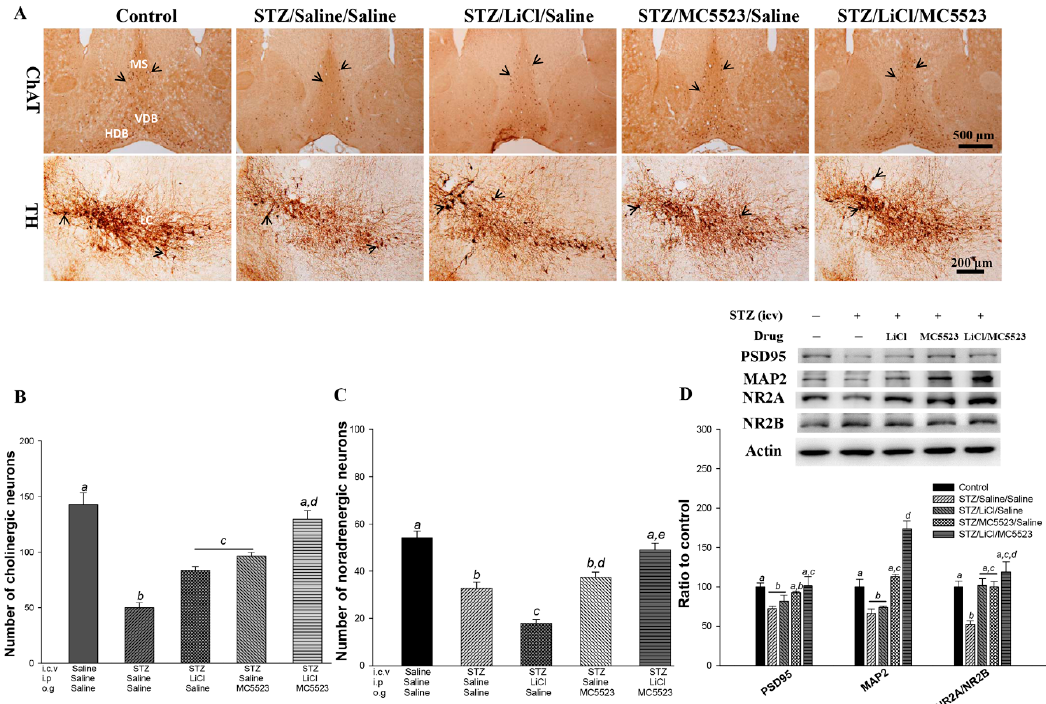
Figure 5. MC5523 prevented neuronal loss and increased the MAP2 level in the LiCl-treated icv-STZ B6 mice. ( A ) Representative images of cholinergic neurons (with ChAT staining) in the MS/DB and noradrenergic neurons (with TH staining) in the locus coeruleus (LC). Scale bars are 500 µ m for ChAT and 200 µ m for TH, and the arrowheads indicate positive staining signals. ( B – C ) Number of cholinergic and noradrenergic neurons. The results show the beneficial effect of LiCl combined with MC5523 on cholinergic and noradrenergic neurons. ( D ) Representative western blots and densitometry results of PSD95 and MAP2 and the NR2A/NR2B ratio with β -actin serving as an internal control. The quantitative data are shown as the mean ± SEM ( n = 3–5 per group). Means that do not share a letter are significantly different ( p <